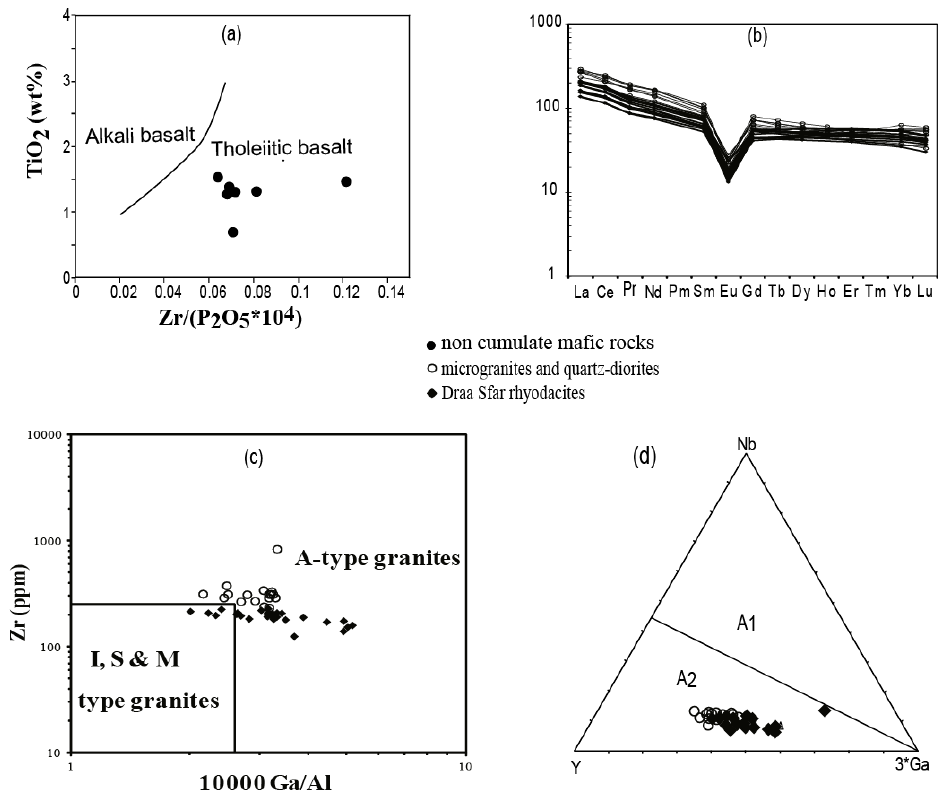
Figure 6. ( a ) Plot of TiO 2 versus Zr/P 2 O 5 for non-cumulate mafic rocks of the Jebilet bimodal intrusive rocks. The fields of alkali and tholeiitic basalts are from [96]; ( b ) Chondrite-normalized REE plot for the felsic volcanic and intrusive rocks of the bimodal association of Central Jebilet. Normalizing values are from Sun and McDonough [97]; ( c ) Jebilet microgranites and rhyodacites in the Zr versus 10 000 Ga/Al diagram of Whalen et al. [98], showing affiliation with A-type granites; and ( d ) Jebilet felsic microgranites and rhyodacites in the Nb–Y–Ga ternary diagram for the subdivision into A 1 - andA 2 -type granites [99]. Data are from [19,53].